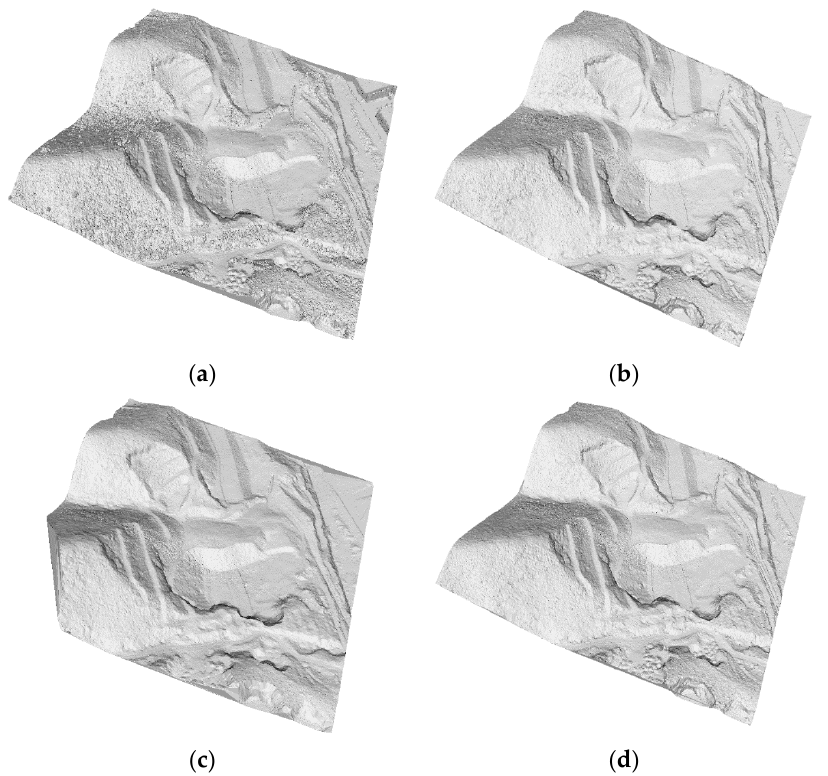
Figure 11. Comparison of the proposed method and TerraScan on the details of the mountain area: ( a ) raw ALS data; ( b ) ground truth; ( c ) result of TerraScan; and ( d ) result of deep CNN model.